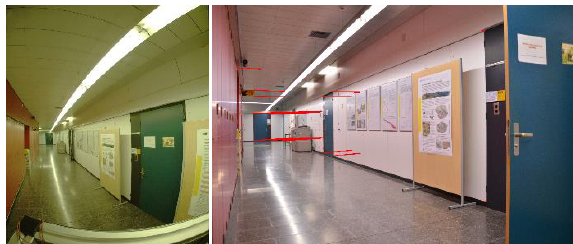
Figure 9. Extreme case where an opened door leads to wrong results. In the reference image (left) the door is closed, in query image (right) it is open. The red lines in the query image indicate the residuals from reprojection.